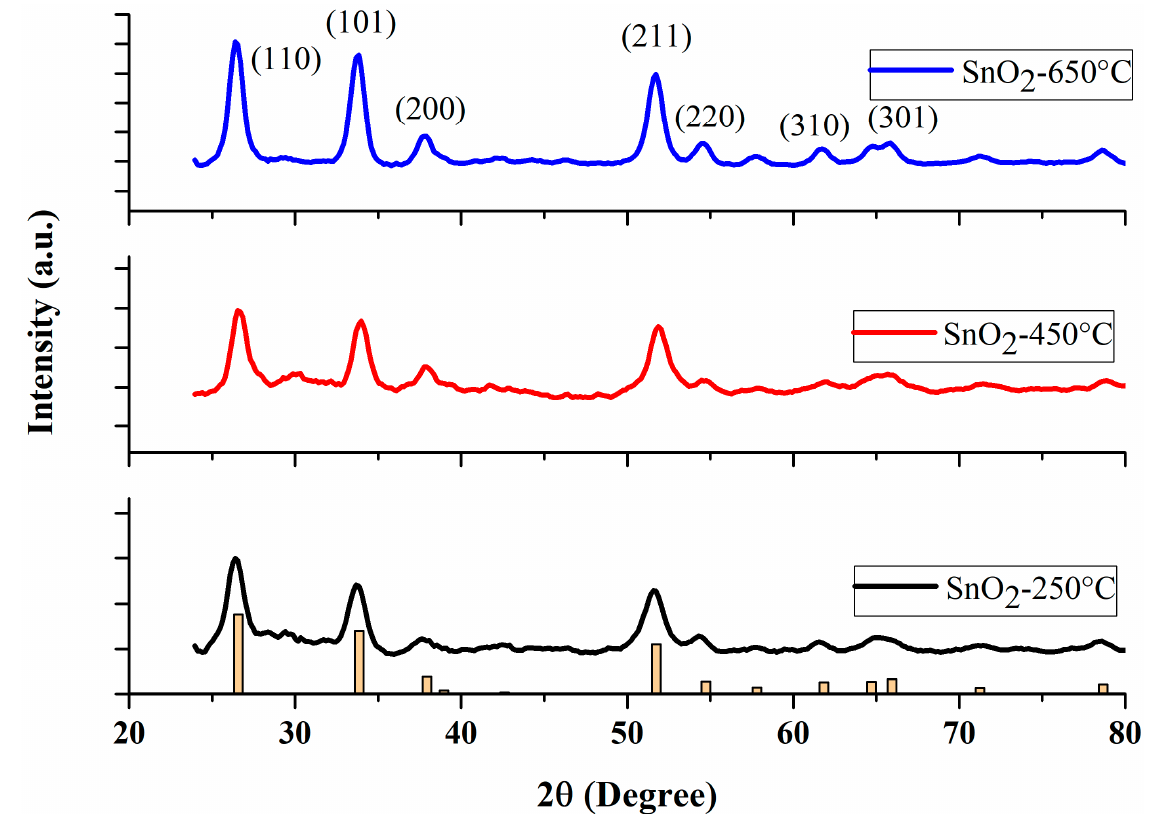
Figure 1. XRD patterns of the SnO 2 nanoparticles at various calcination temperatures. (Yellow bar chart represents the diffractogram of the JCPDS card).